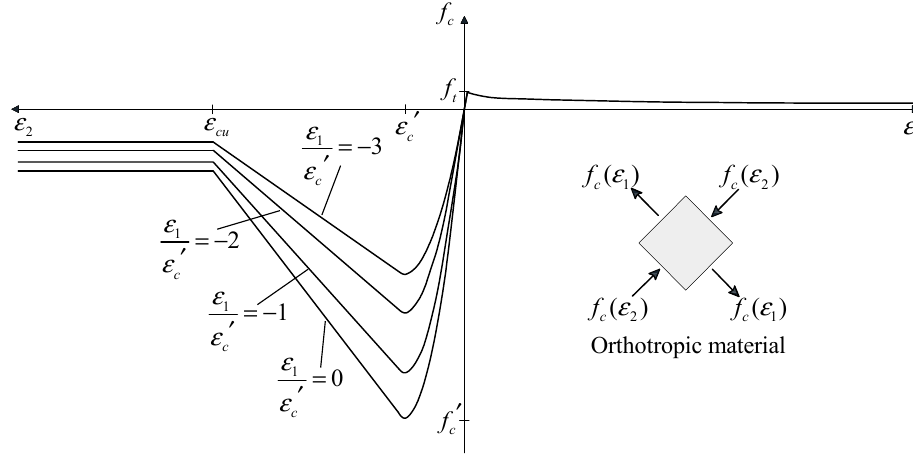
Figure 3. Behavior of concrete material.